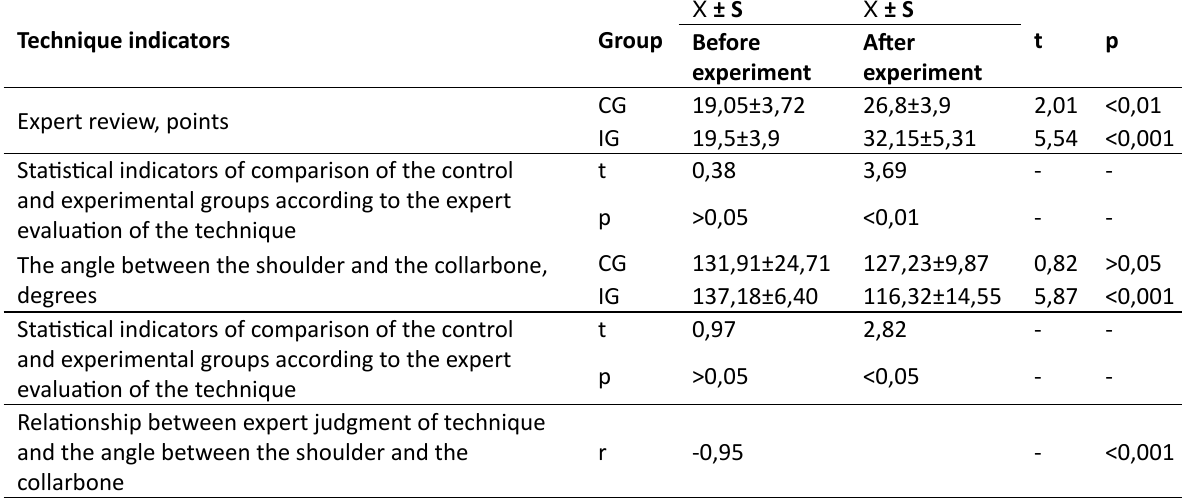
Table 2. Indicators of hanging technique fulfillment in rock climbing by athletes from the control group (n = 44) and the intervention group (n = 40) before and after the experiment